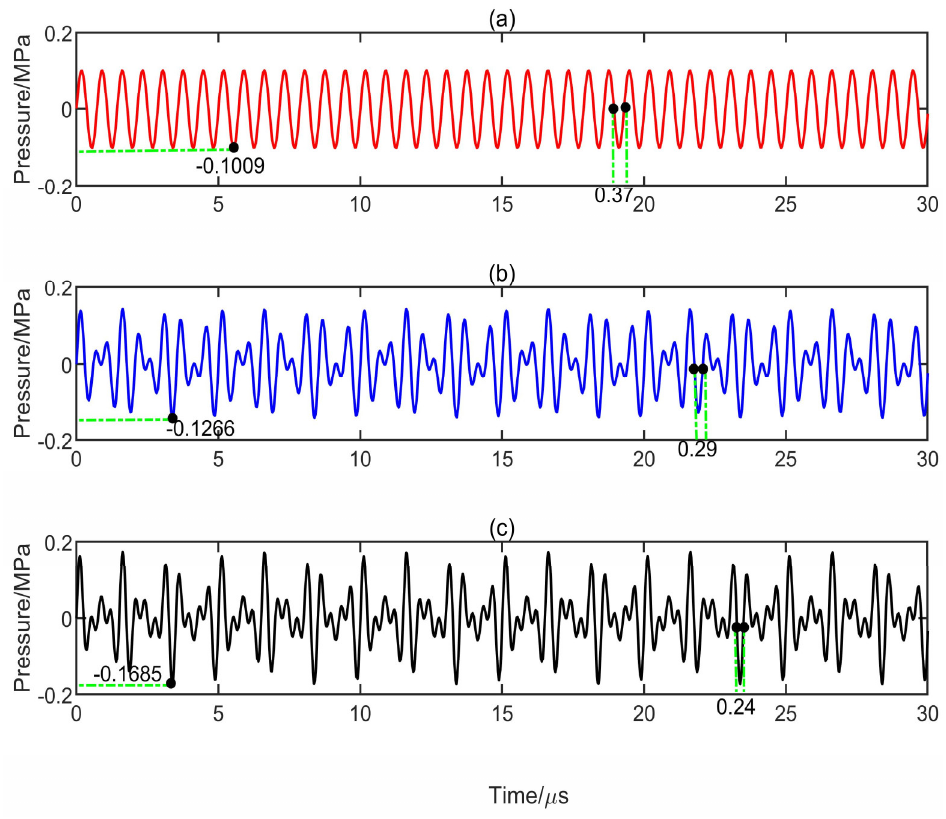
Figure5. Pressurewaveformsofdi ff erentfrequencycombinationsinliver: ( a )1.4MHz; ( b )1.4 + 2.0MHz; ( c ) 1.4 + 2.0 + 2.6 Figure 5. Pressure waveforms of different frequency combinations in liver: ( a ) 1.4 MHz; ( b ) 1.4 + 2.0 MHz; ( c ) 1.4 + 2.0 + 2.6 MHz.